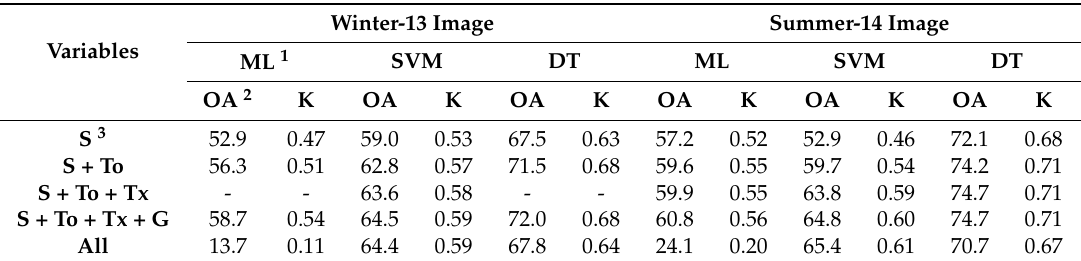
Table 5. Best classification accuracies obtained with combination of advanced object-based and topographical variables in winter and summer images using Maximum Likelihood, Support Vector Machine and Decision Tree algorithms. Winter-13 Variables